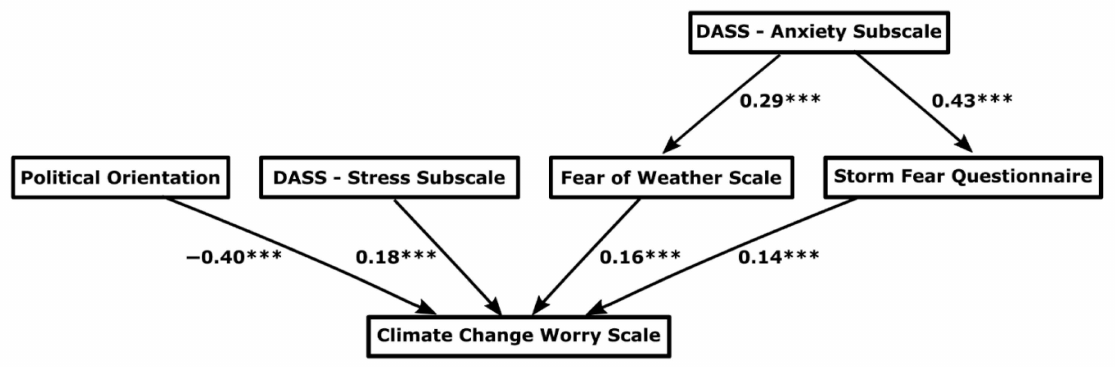
Figure 4. Path analysis model predicting scores on the Climate Change Worry Scale. Note: Values displayed are standardized regression coefficients. *** p ≤ 0.001, and R 2 adj =